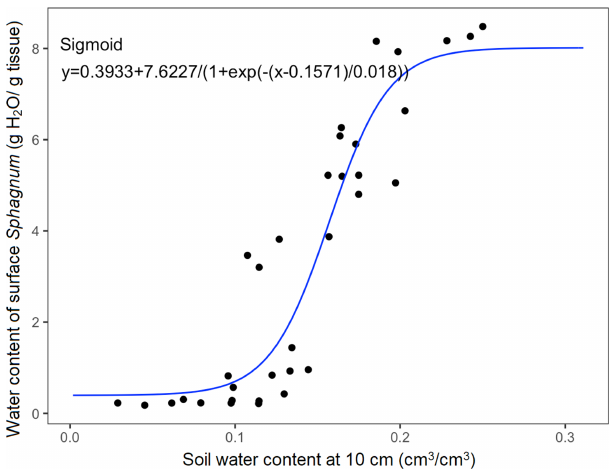
Figure 1. The measured relationship between soil water content at depth and the water content of surface Sphagnum based on destruc- tive